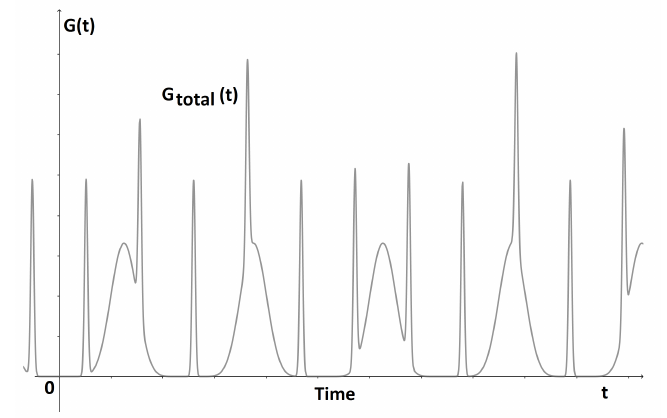
Figure 11. The equivalent conductance G eq ( t )